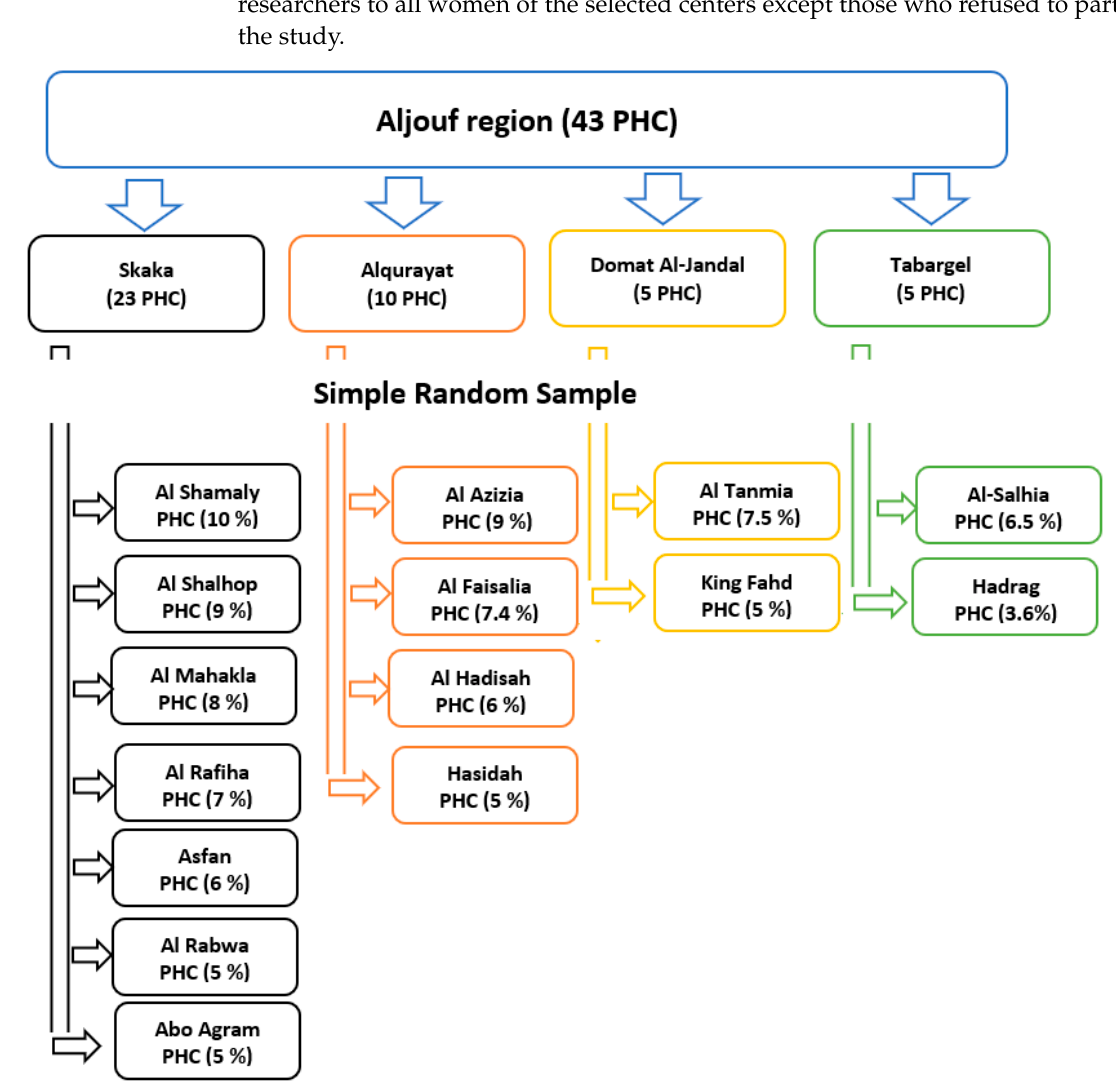
Figure 1. Schematic diagram of the sampling technique.